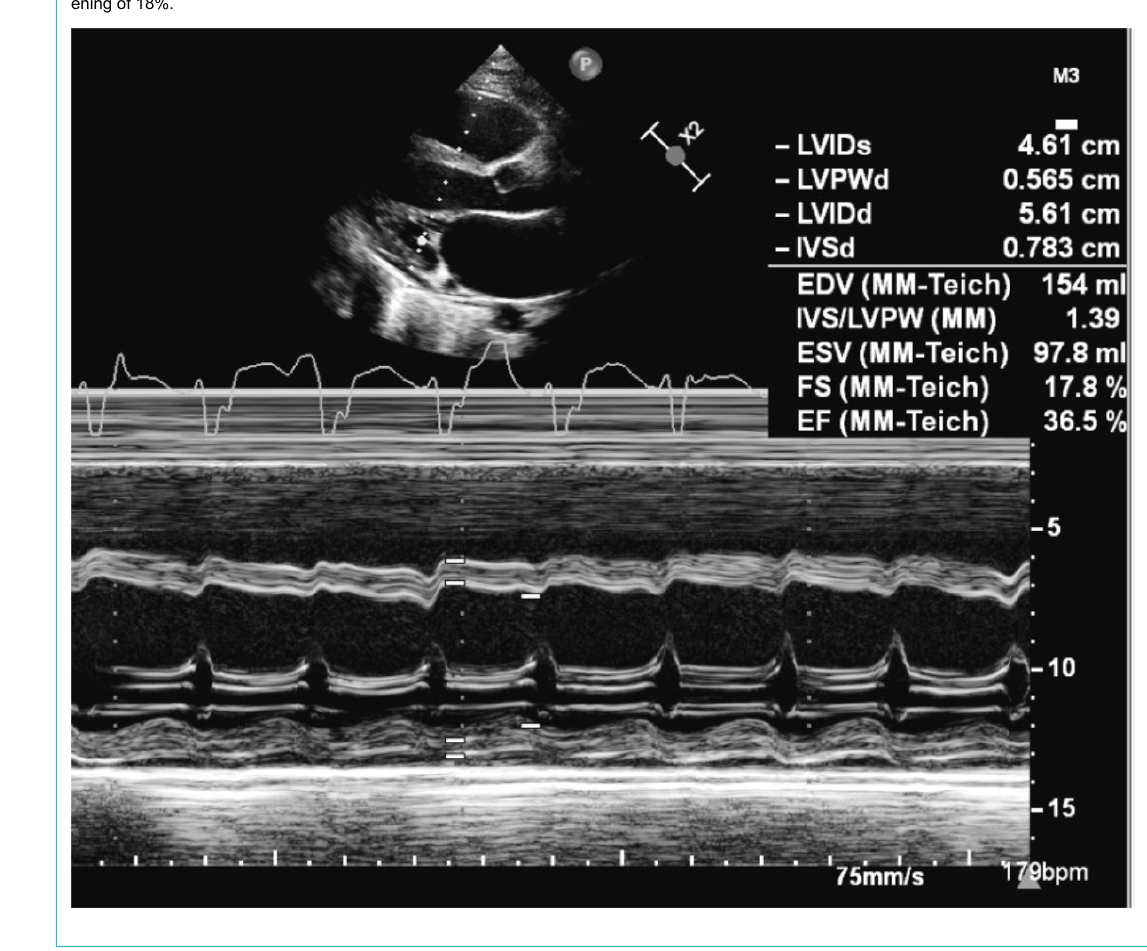
Figure 2: Transthoracic 2D echocardiography at admission showed severe reduced left ventricular function on M-mode with a fractional short- ening of